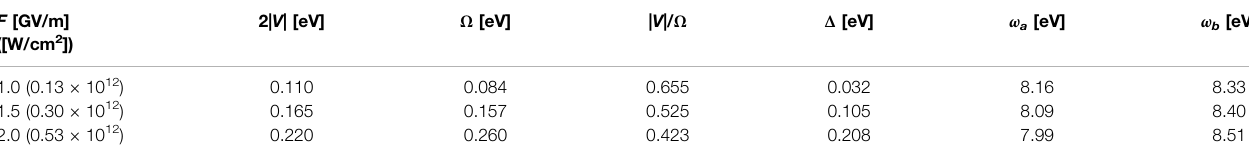
TABLE 3A | Input parameter F ( ≡ F a ) and other parameters for a generation of unidirectional π -electron rotation in toluene. F [GV/m] ([W/cm 2 ])